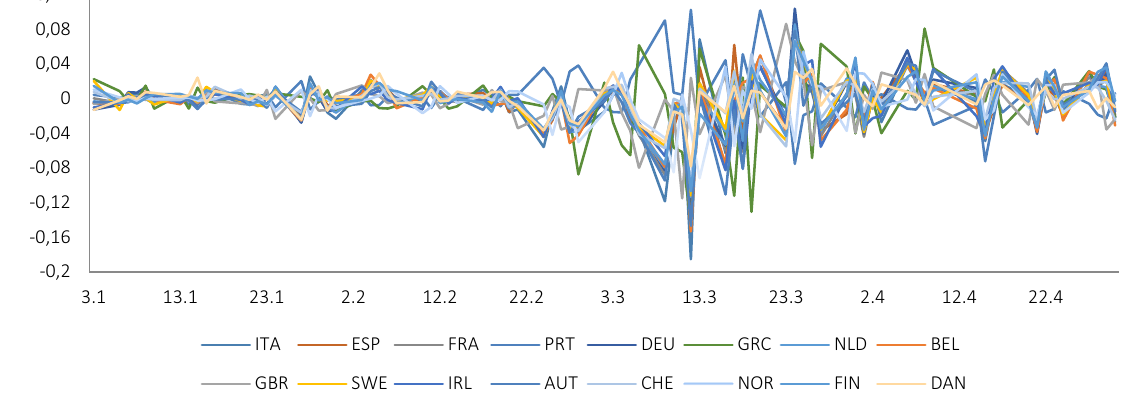
Figure 2. Stock returns per European